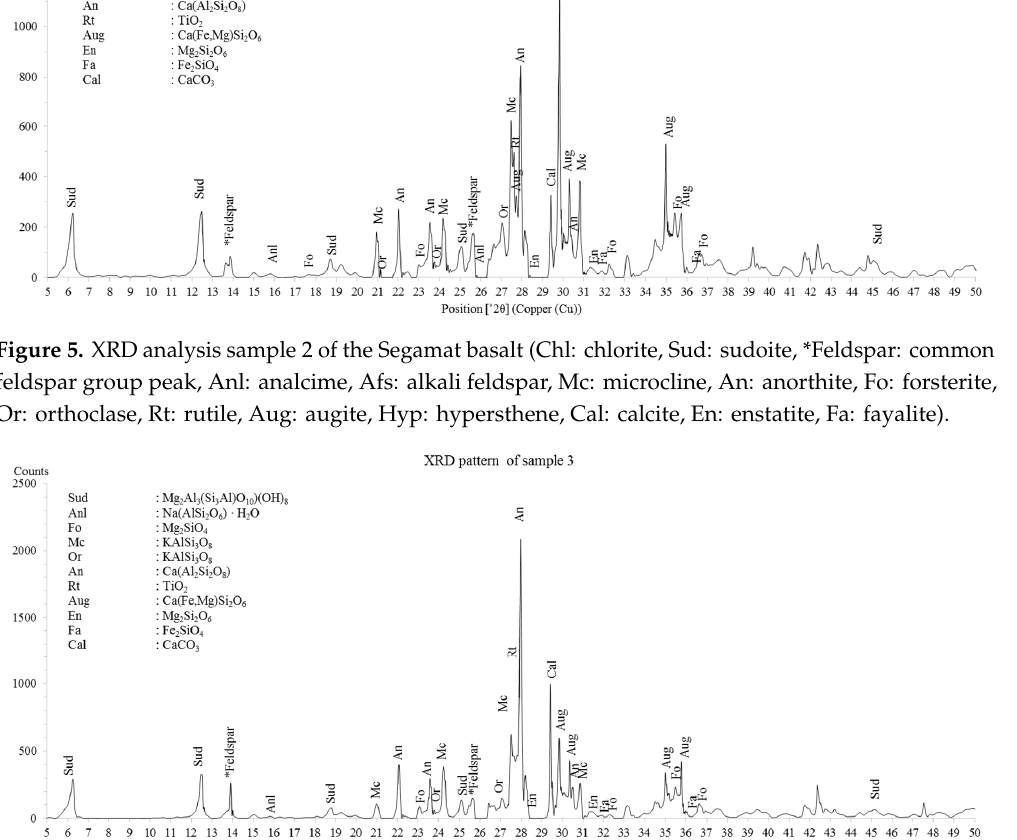
Figure 6. XRD analysis of sample 3 of the Segamat Basalt (Chl: chlorite, Sud: sudoite, *Feldspar: common feldspar group peak, Anl: analcime, Afs: alkali feldspar, Mc: microcline, An: anorthite, Fo: forsterite, Or: orthoclase, Rt: rutile, Aug: augite, Hyp: hypersthene, Cal: calcite, En: enstatite, Fa: fayalite).